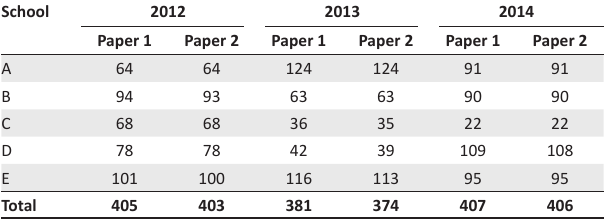
TABLE 1: Number of learners per school, per year and per